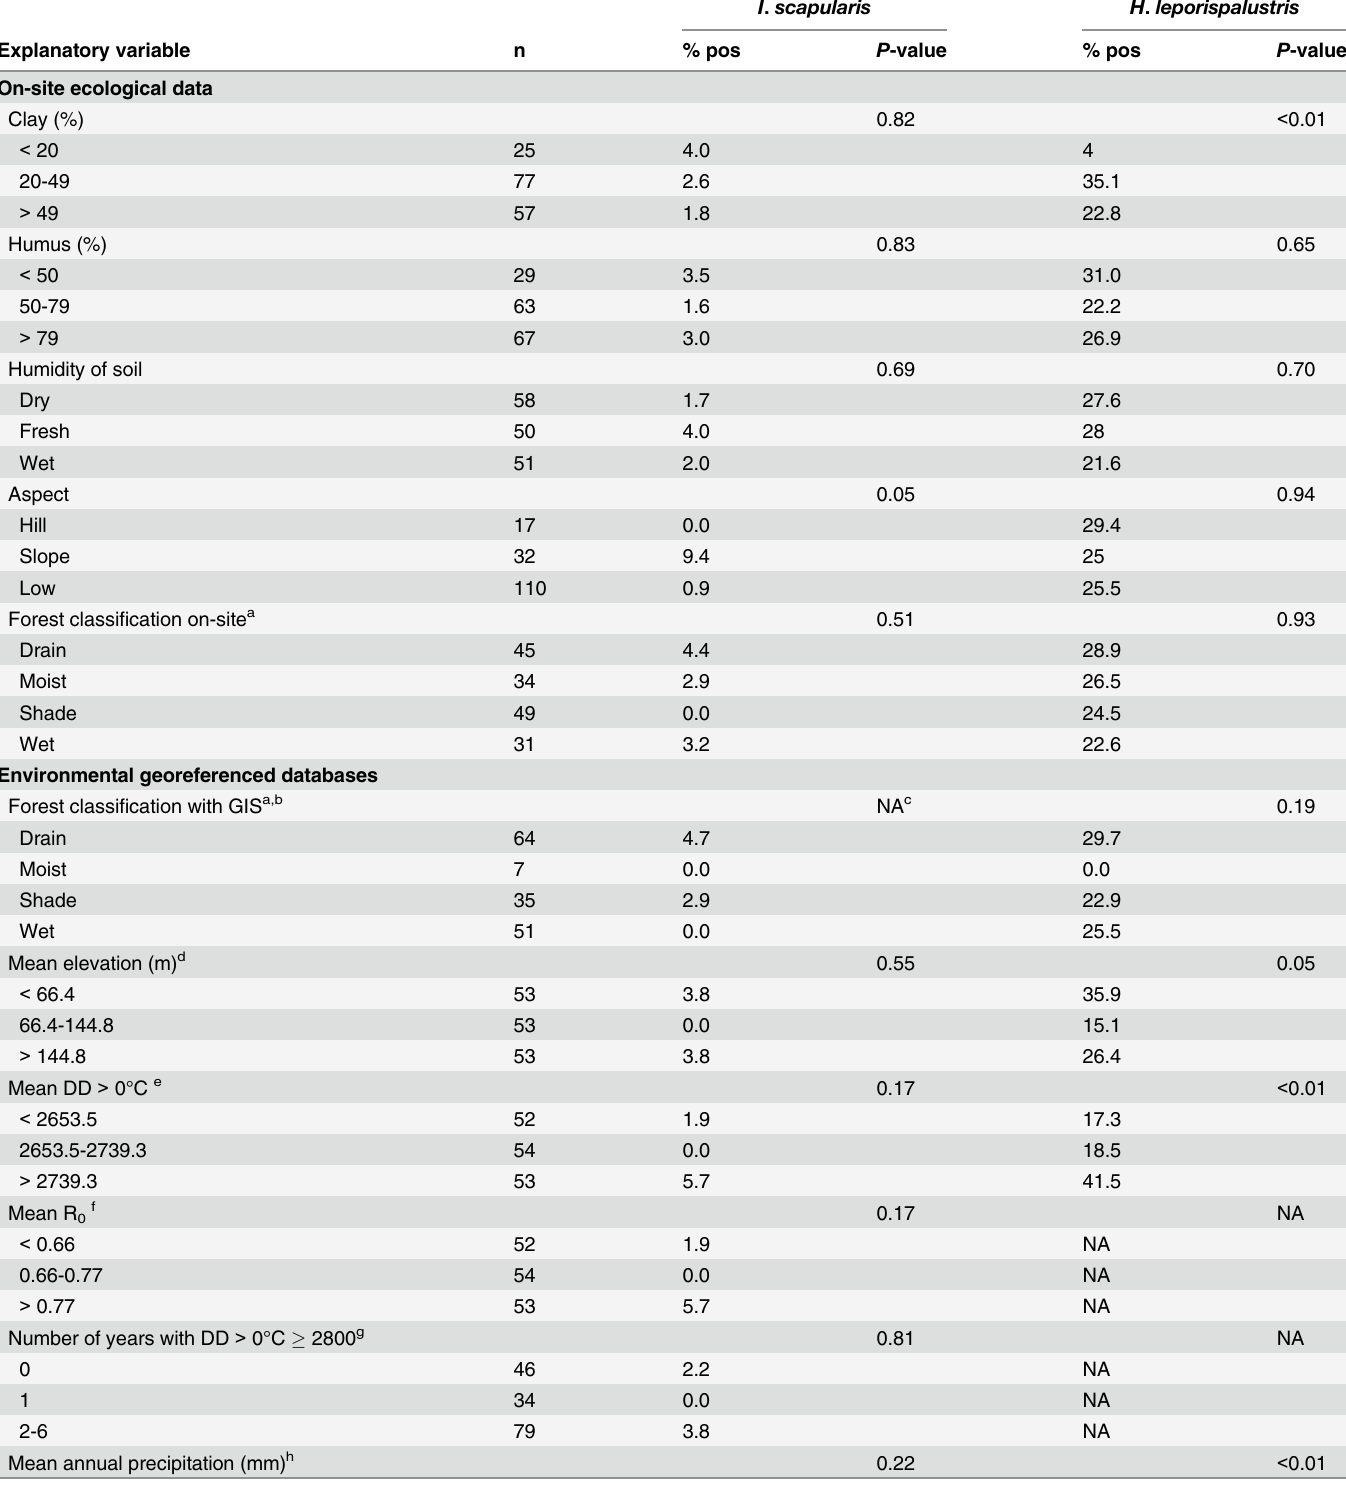
Table 1. Descriptive statistics of explanatory variables and results from univariate analyses for occurrence of I . scapularis and H . leporispalustris at the 159 field sites visited during the